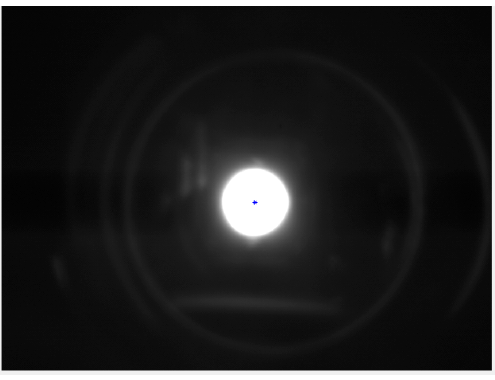
Figure 10. Sample image gathered by the pinhole sensor and detected centroid.